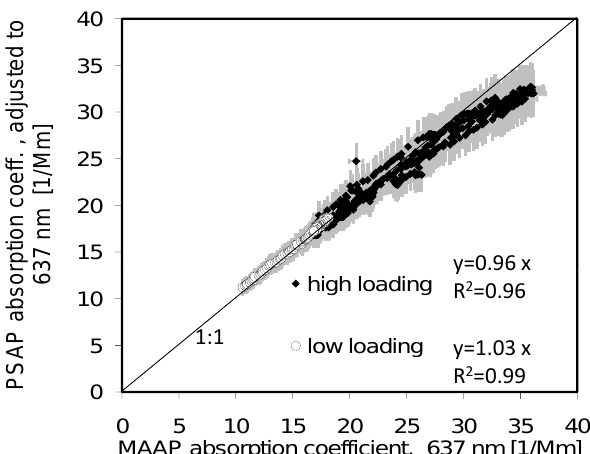
Fig. 7. Ambient air Exp. 2 during the EUSAAR2007 workshop. PSAP absorption coefficients adjusted to 637nm vs. MAAP absorp- tion coefficients at 637nm. The error bars represent the unit to unit variability of 3% and 8% for the MAAP and the PSAP, respectively. Data points for low loading are for data with PSAP transmittance between 1.0 and 0.7; high loading is for data with PSAP transmit- tance between 0.7 and to 0.2.